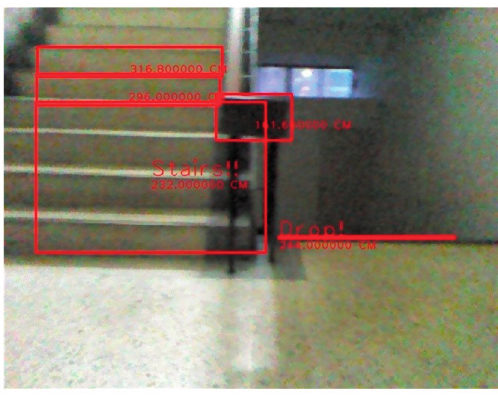
Figure 19. The result of